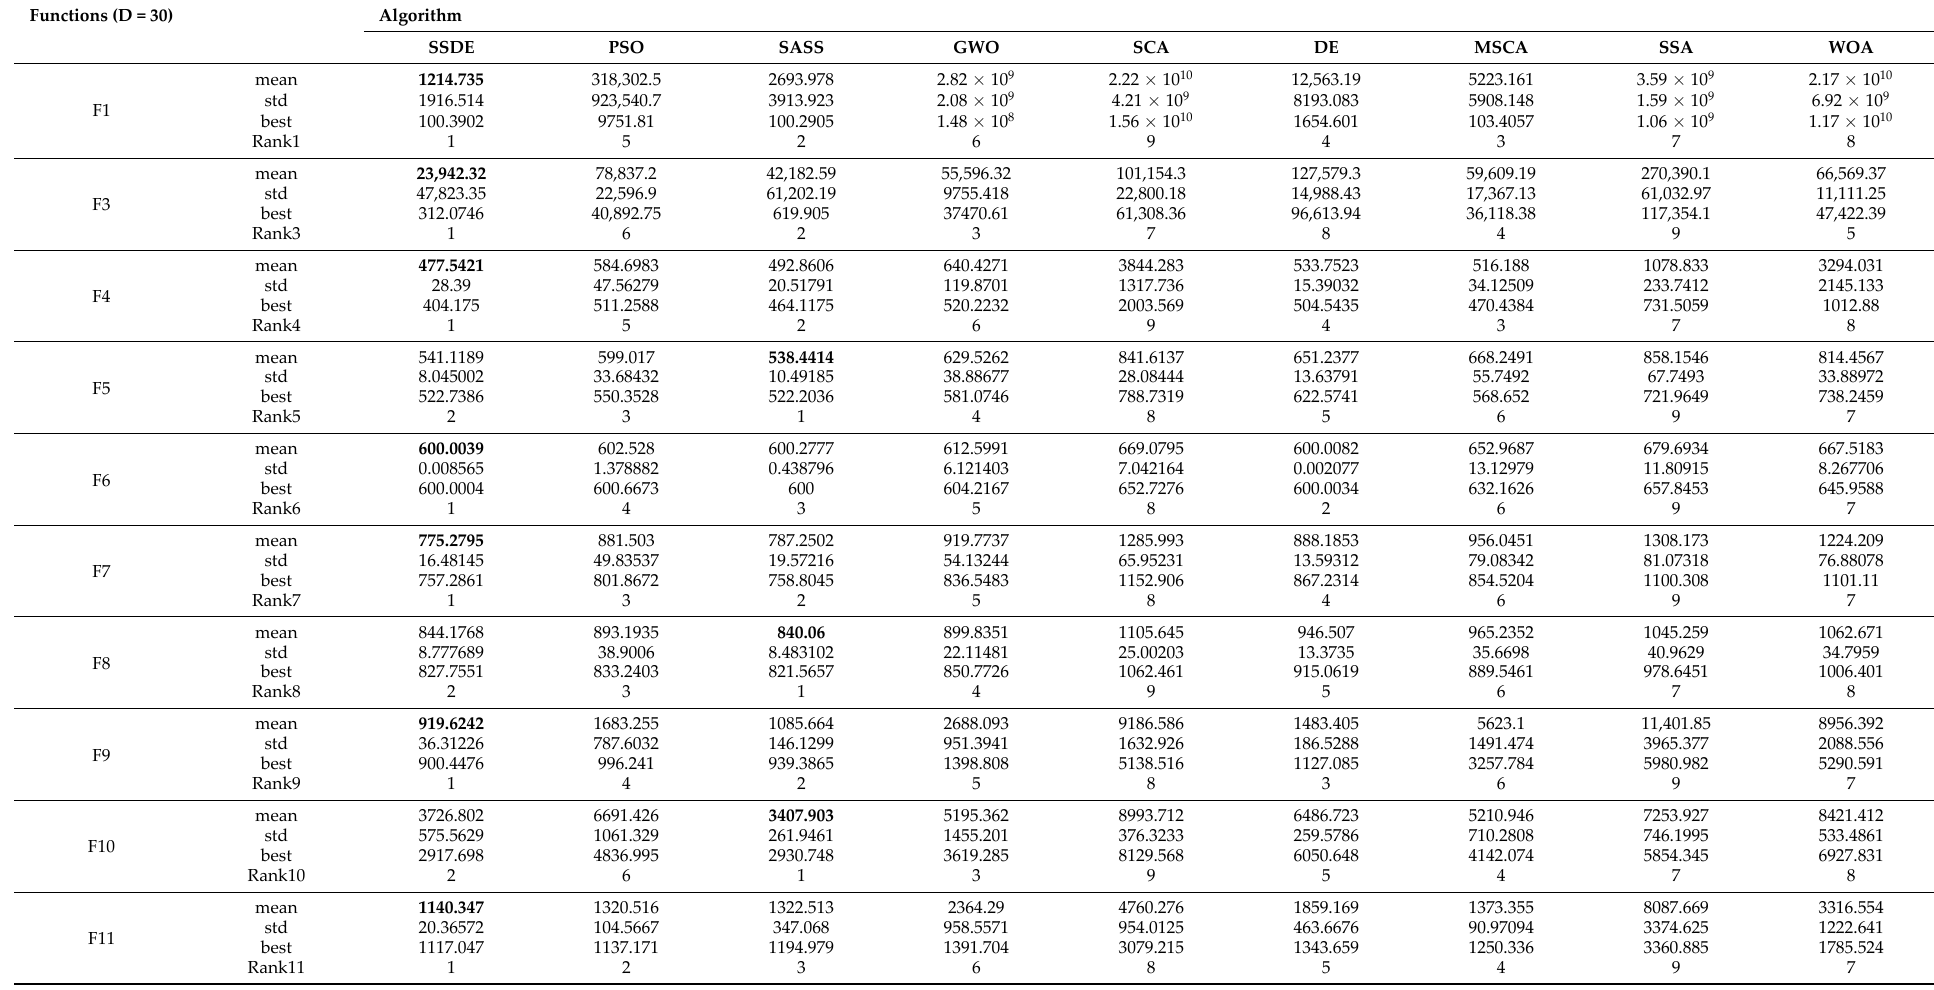
Table 4. Experimental results of IEEE CEC 2017 test problems with 30